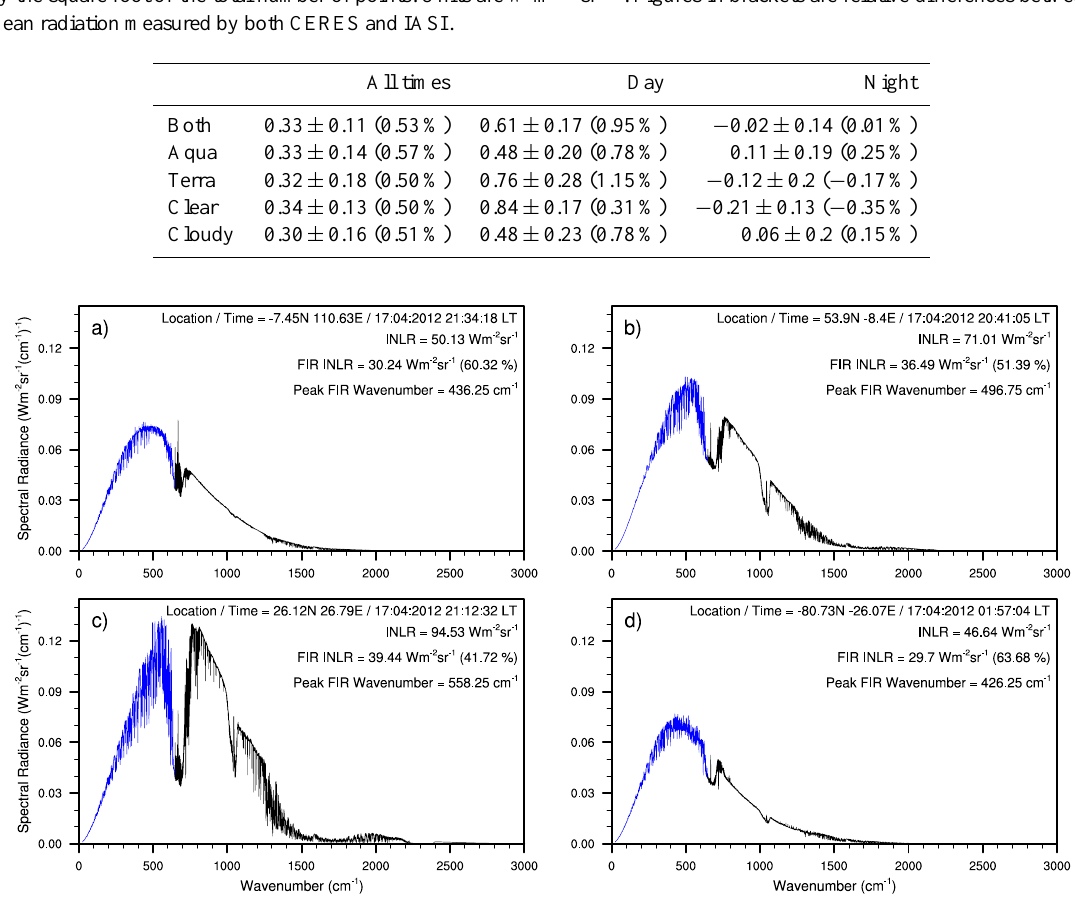
Figure 12. The total outgoing long-wave spectral radiances (25.25–2999.75cm − 1 ) constructed from IASI measurements (black) and esti- mated far infrared radiance (blue) for four instantaneous scenes over: (a) tropical equatorial land, (b) midlatitude land, (c) the Sahara desert and (d) Antarctica. All are night-time scenes from the 17 April